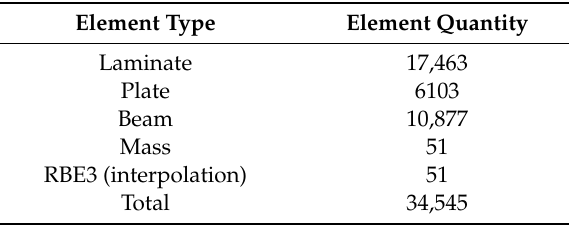
Figure 2. Structural mesh (34,545 elements and 16,239 nodes). Table 3. FEA